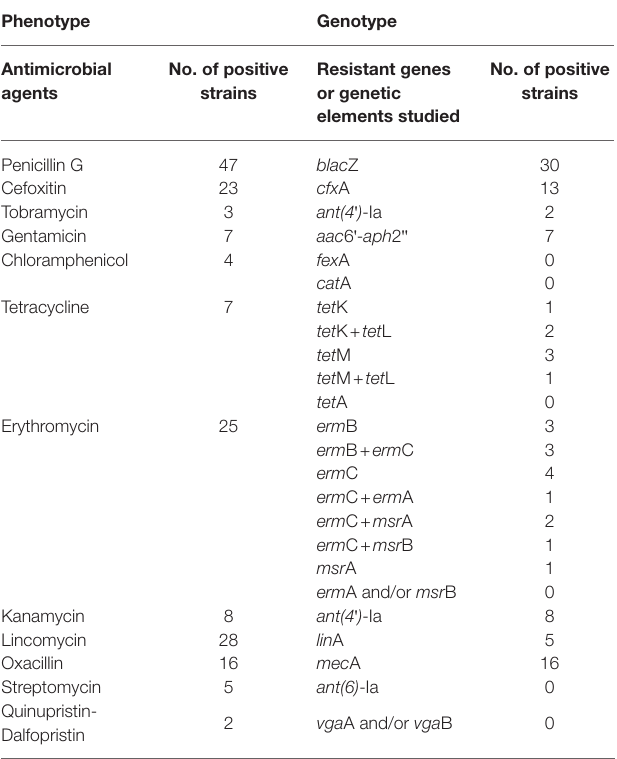
TABLE 4 | Antimicrobial resistance genes among E. coli